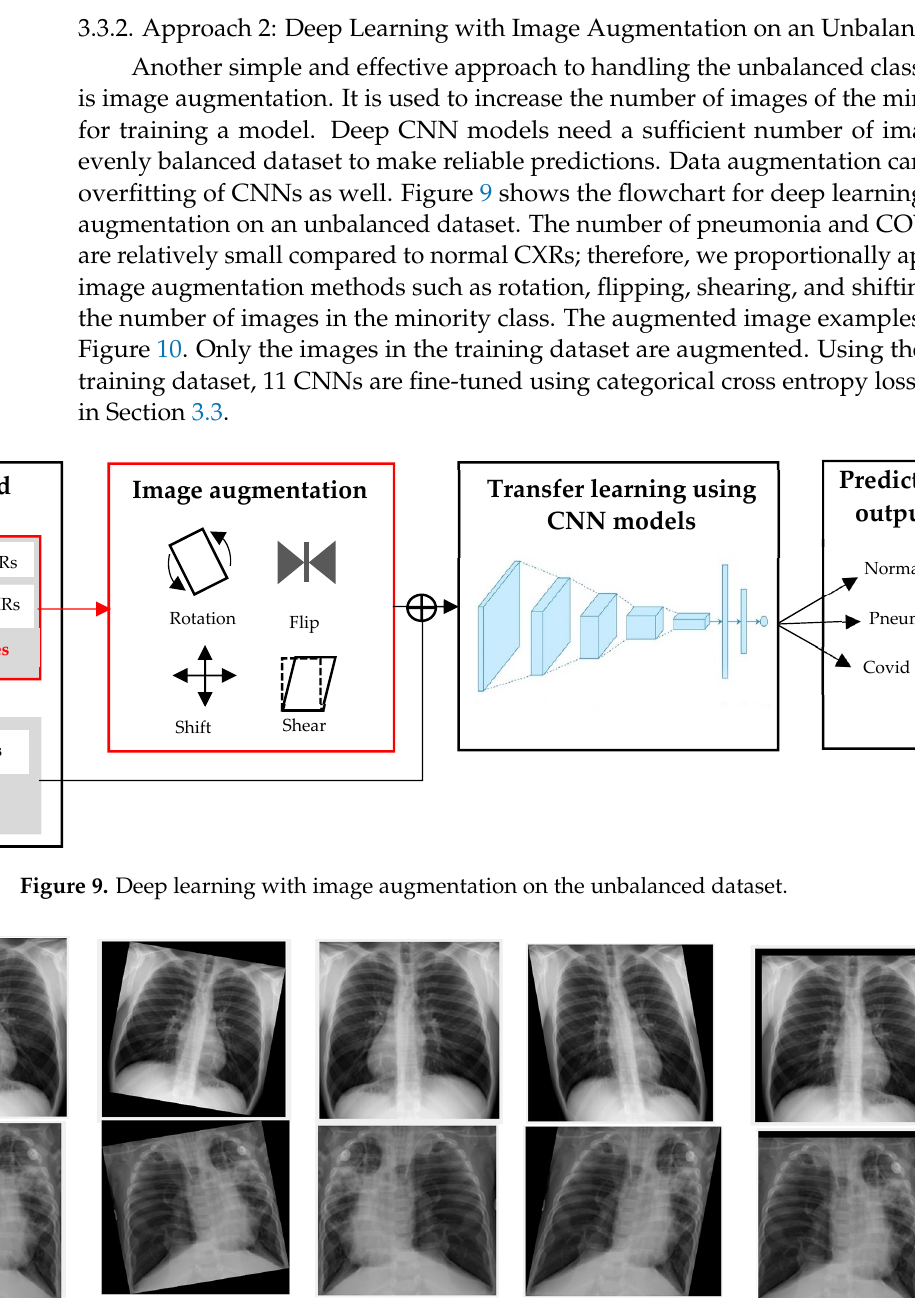
Figure 8. The contribution of positive and negative labels within each class.